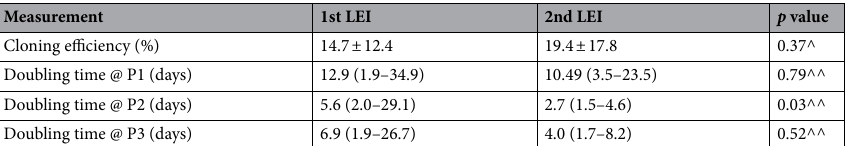
Table 2. SUSD2 + eMSCs Growth Kinetics. Cloning efficiency data are mean ± SD of 6 samples/group, ^paired Student’s t-test. Doubling time data are median (range) of n = 6 samples/group ^^ Mann–Whitney